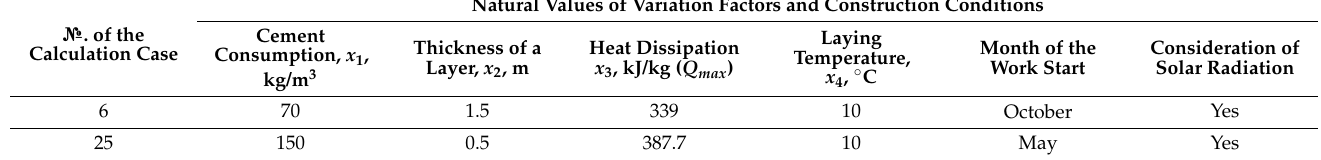
Table 2. Parameters of the calculation cases